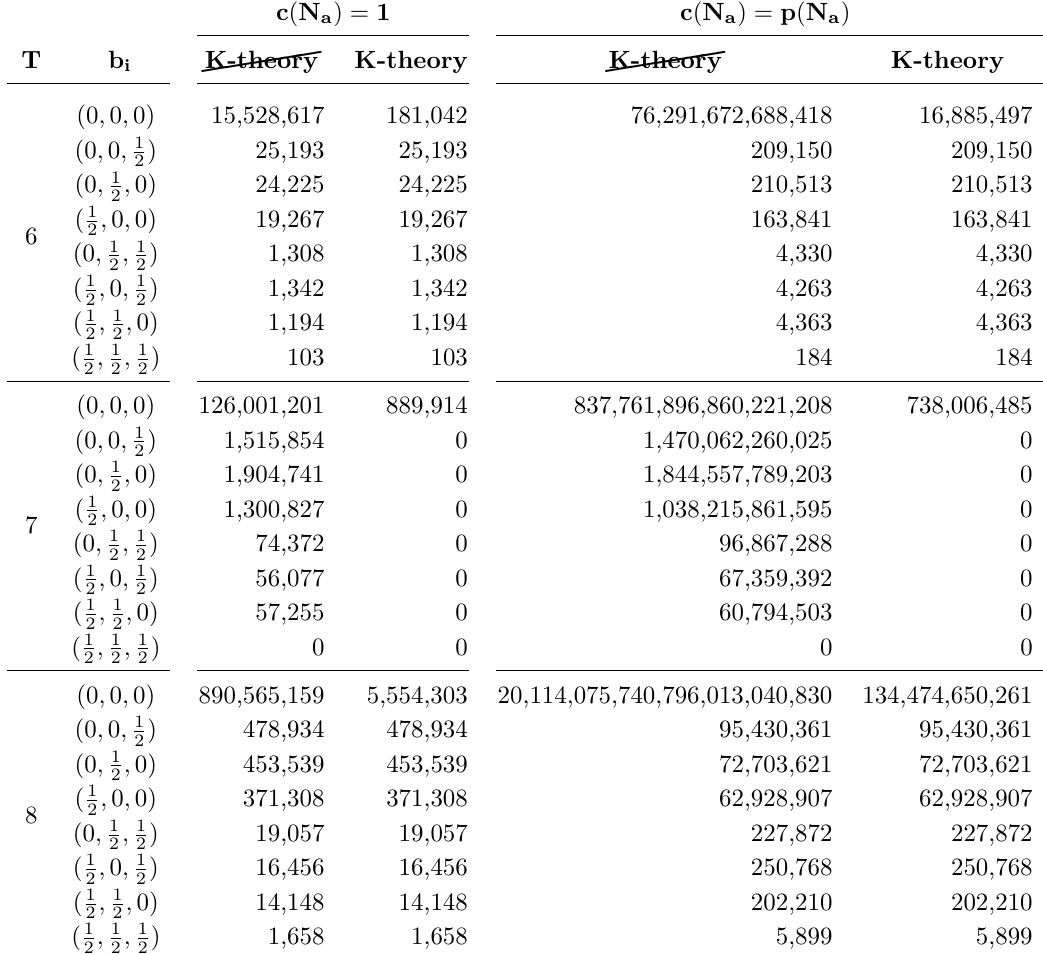
Table 2. Exact number of vacua with 0 < b U 0 ≤ b U 1 ≤ b U 2 ≤ b U 3 for all T ≤ 8 , all choices